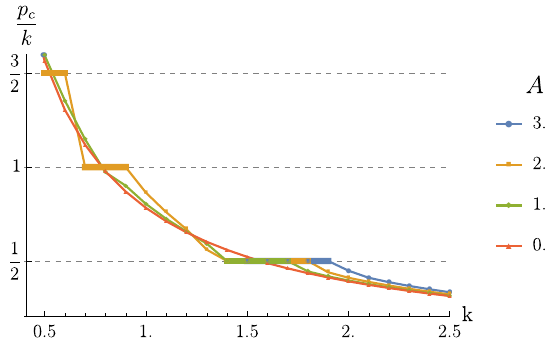
Figure 6 . Same data as (cid:12)gure 5 rescaled to show the relation between p c and k . The characteristic \ladder" shape and the lock-in plateaus (bold lines) are